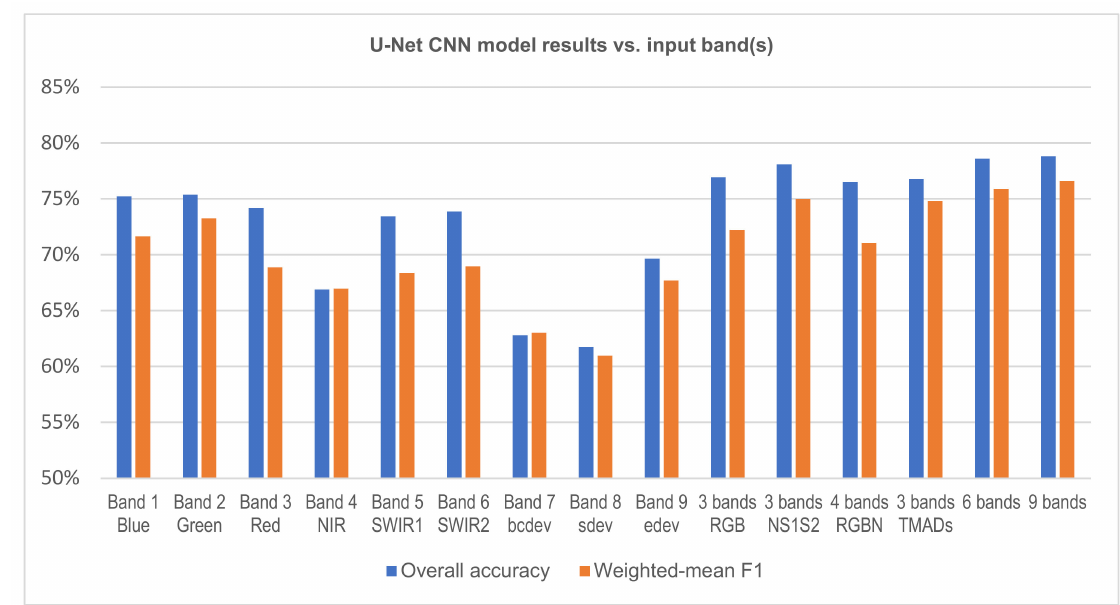
Figure 5. Impact of Landsat input bands on U-Net CNN model OA and F1